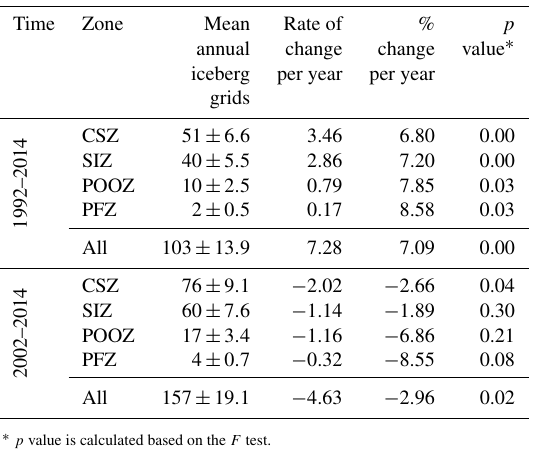
Table 6. Temporal trend of large icebergs: mean annual number of grids occupied by large icebergs by ecological zones.